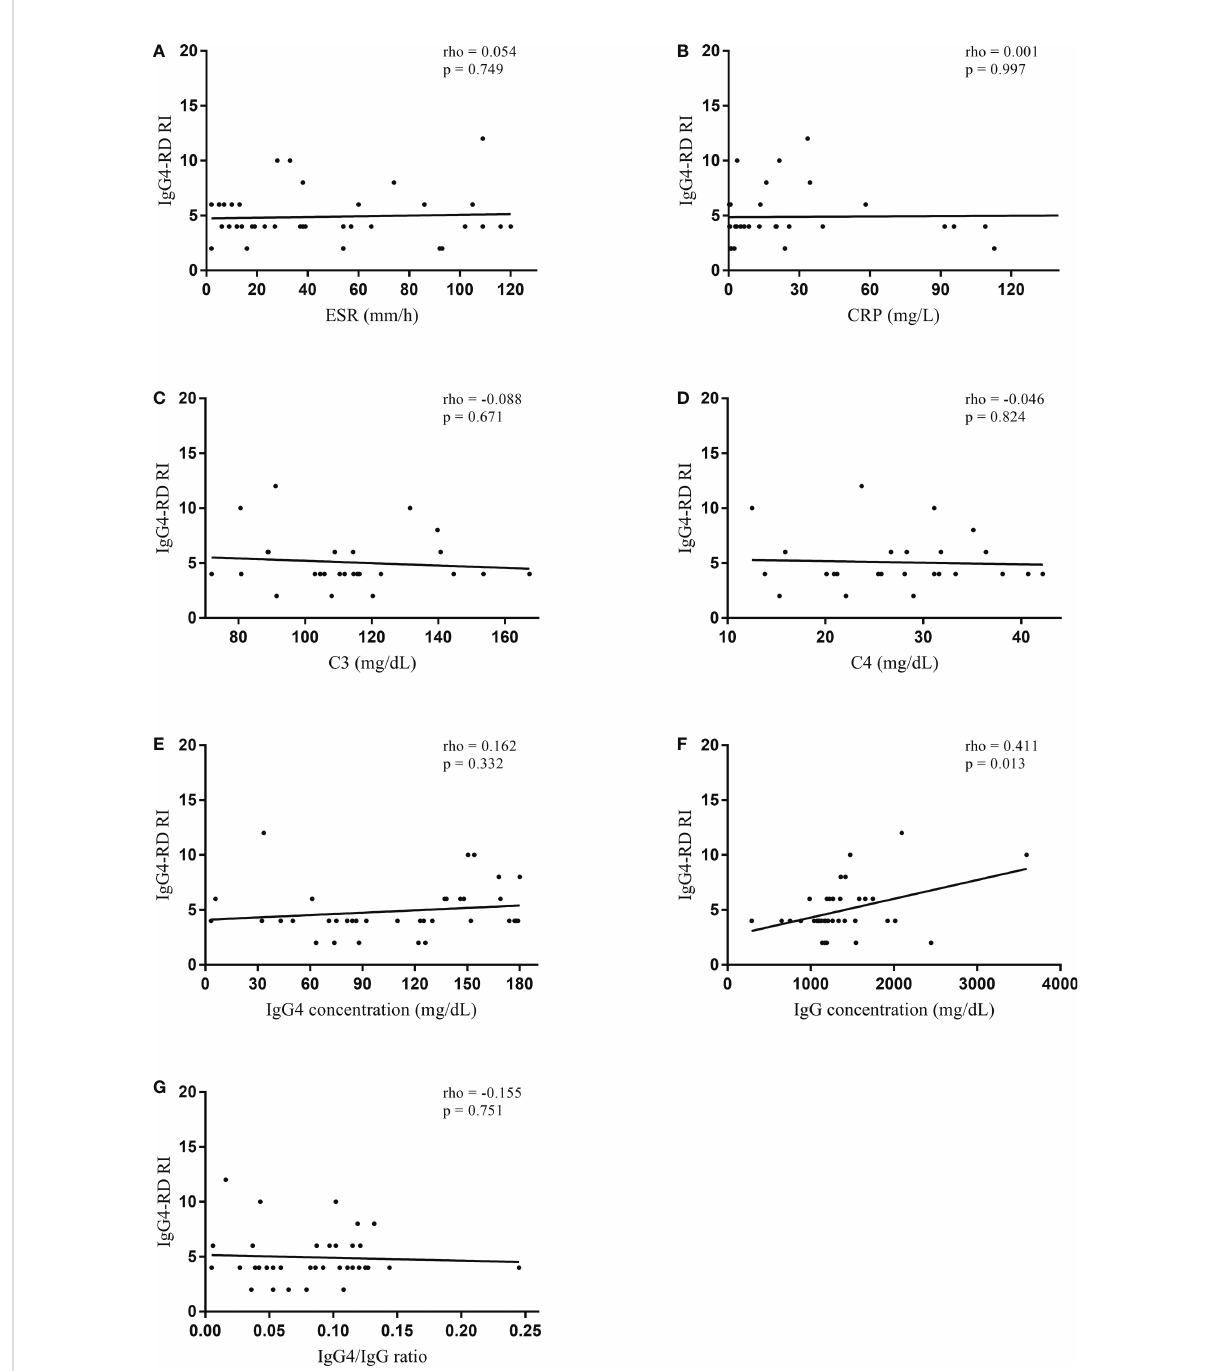
FIGURE 1 Spearman ’ s correlation coef fi cient between serologic parameters and IgG4-RD RI in the normal serum IgG4 concentration group. (A) ESR, (B) CRP, (C) C3, (D) C4, (E) IgG4 concentration, (F) IgG concentration, and (G) IgG4/IgG ratio. IgG4-RD, IgG4-related disease; RI, responder index; ESR, erythrocyte sedimentation rate; CRP, C-reactive